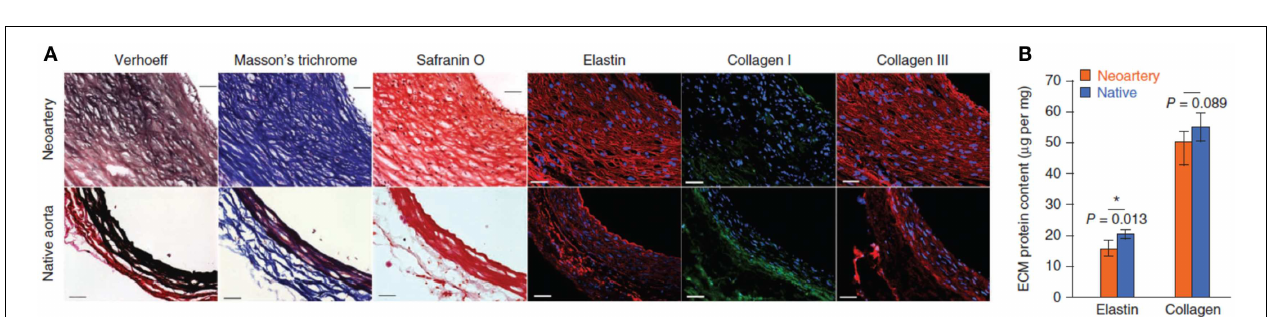
FIGURE 3 | Smooth muscle cell infiltration and organization at 14days . (A) SMC distribution (SM α A, green) within the remodeled graft wall.The tissue was split longitudinally, half of which is shown. Native aorta is on the right; its border with the graft is indicated by the dashed line; scale bar, 500 µ m. L, lumen. (B) Magnified view of the mid-graft shows distribution of both SM α A-positive (green) and SM α A-negative cells. Nuclei counterstained by DAPI (blue); scale bar, 250 µ m. (C) Further magnification of the mid-graft to